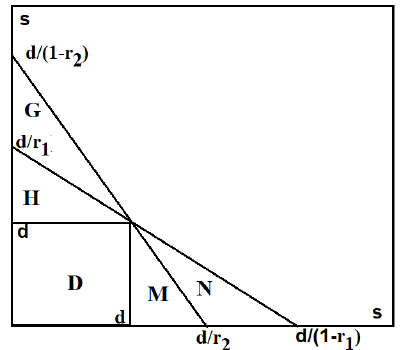
Figure 1. Long positions.